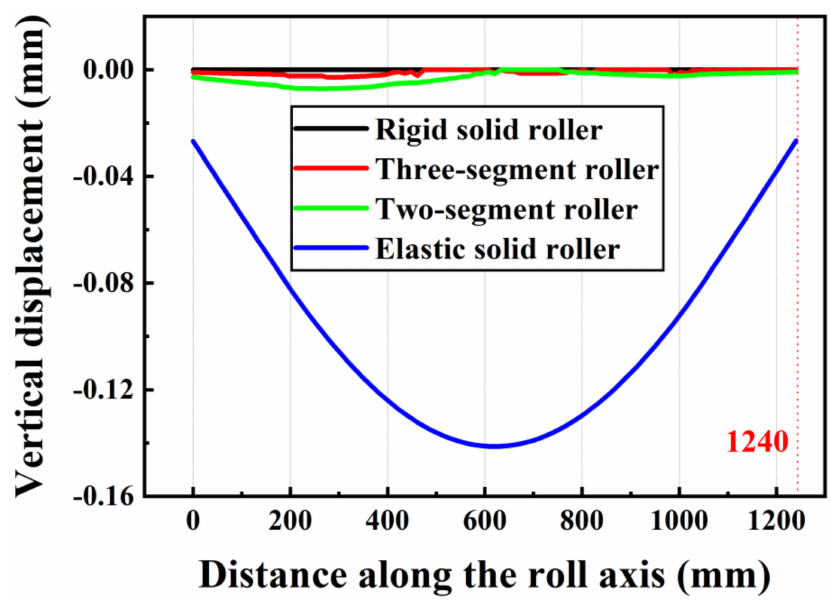
Figure 9. The vertical displacement of different casting rollers.